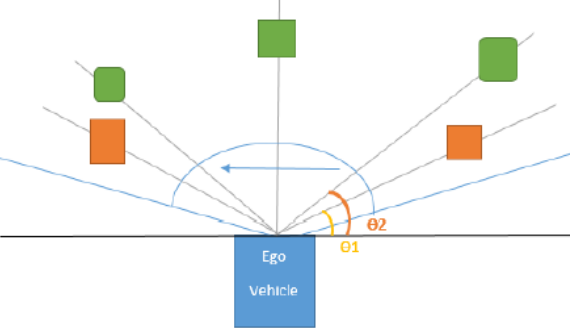
Figure 6. 2D sweeping polar rays for object association are depicted in a light blue color. In orange, we illustrate motion-corrected trifocal objects, and in green, the target objects.